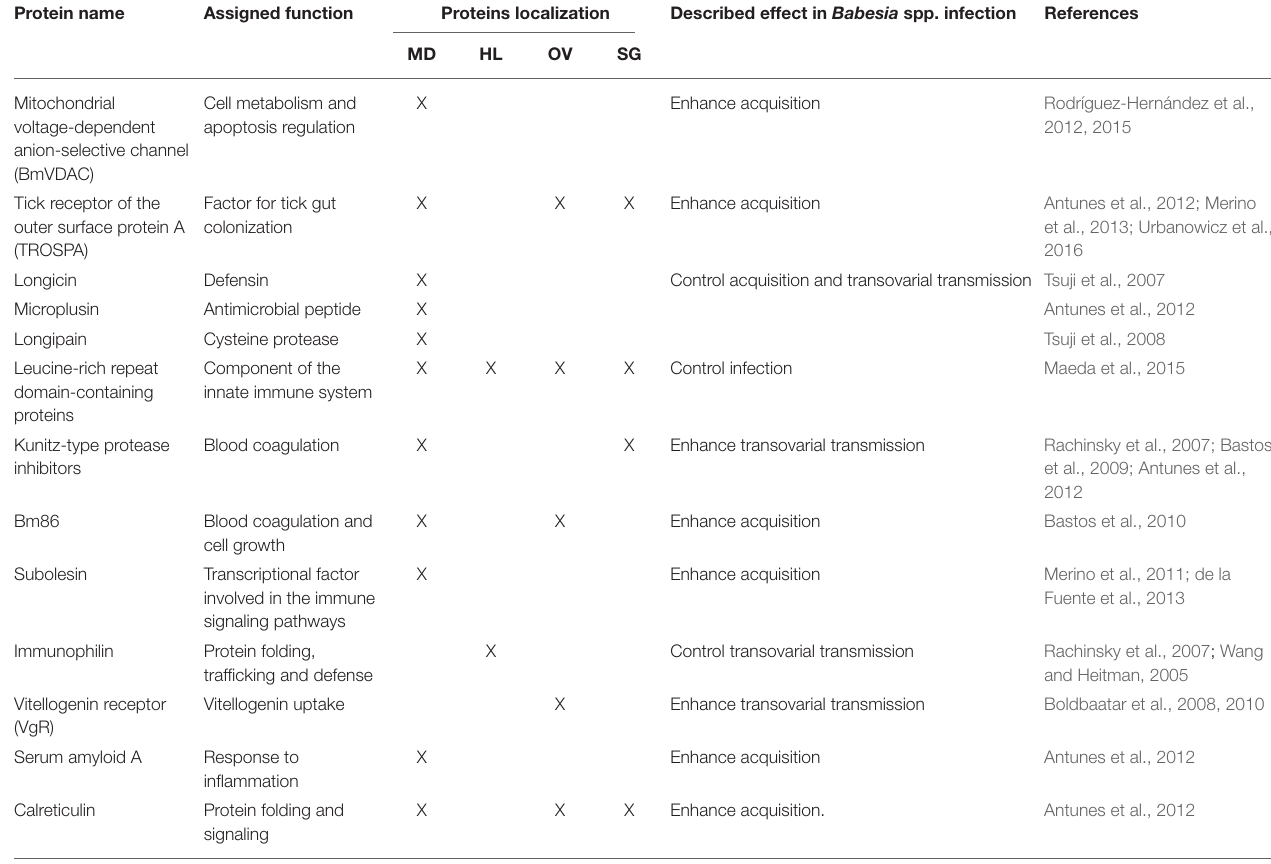
TABLE 1 | Tick molecules interfering with Babesia spp.